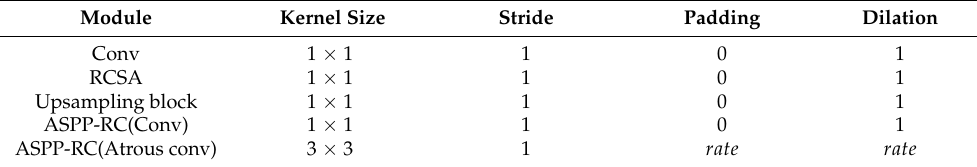
Table 2. Parameters used for the convolution kernels in the various modules in RCSANet. Module Kernel Size Stride Padding Dilation Conv 1 × 1 1 0 1 RCSA 1 × 1 1 0 1 Upsampling block 1 × 1 1 0 1 ASPP-RC(Conv) 1 ×